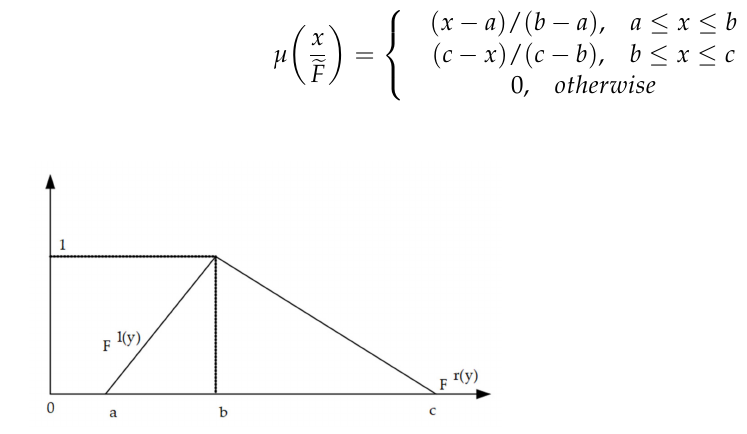
Figure 2. The membership function of